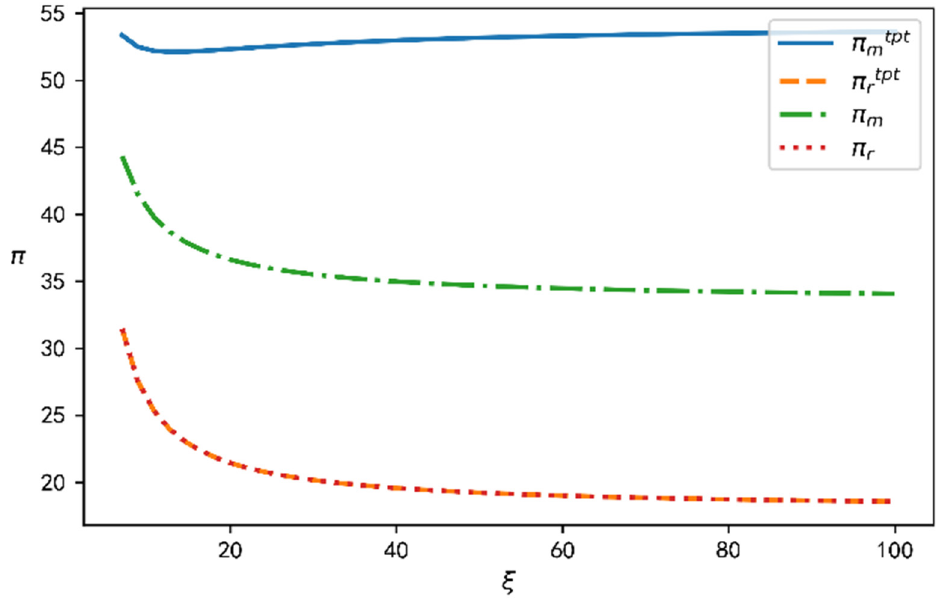
Figure 7. Change in profits before and after coordination.